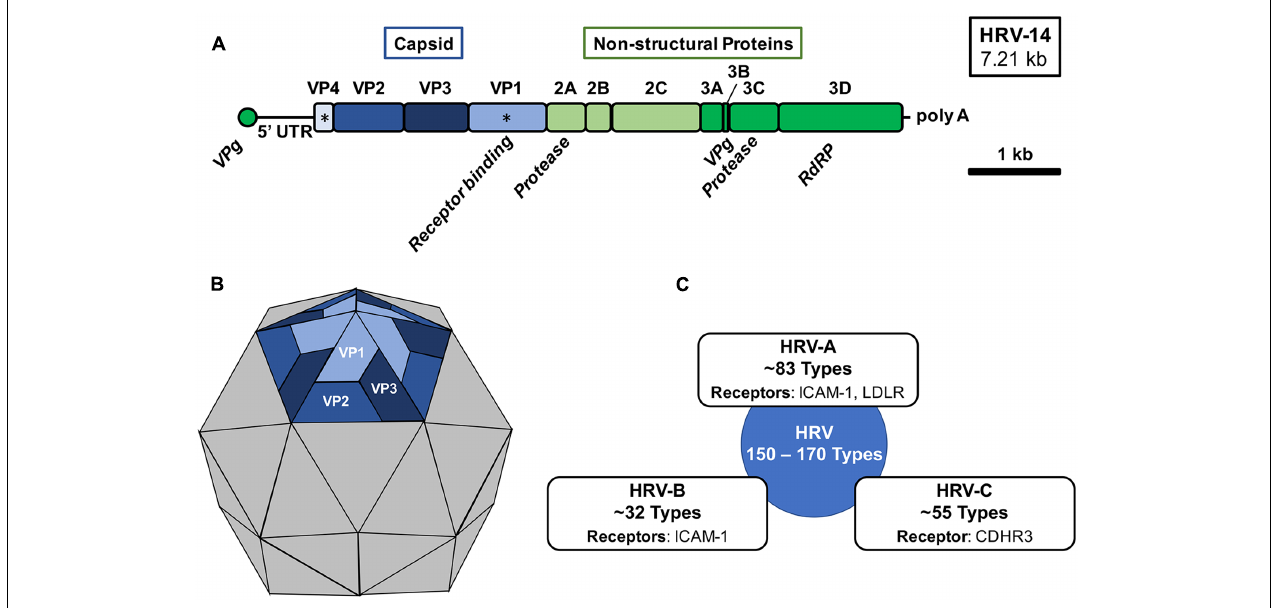
FIGURE 1 | Human rhinovirus genomic organization, virion structure, and species. (A) The 7.21 kb +ssRNA genome of HRV-16 is comprised of a single open-reading frame encoding 11 gene products, which upon translation into three distinct polyproteins are cleaved by HRV-encoded proteases (2A and 3C). The 5 (cid:48) -end of the genome is capped with a short viral priming protein (VPg) for incorporation during virion assembly and a the 3 (cid:48) -end is polyadenylated. Capsid proteins VP1 and VP4 ( ∗ ) are generally used for phylogenetic analysis. RdRP, RNA-dependent RNA polymerase; UTR, untranslated region. (B) An icosahedral virion structure of HRV with a pentamer structure shown highlighting the external capsid proteins (VP1, VP2, and VP3) organization. VP1 is responsible for receptor engagement and VP4 is located beneath each monomeric unit and is responsible for genomic association with VPg. (C) Three distinct species of human rhinovirus have been identified (HRV-A, HRV-B, and HRV-C). The approximate number of types within each species classification and known receptors of each are